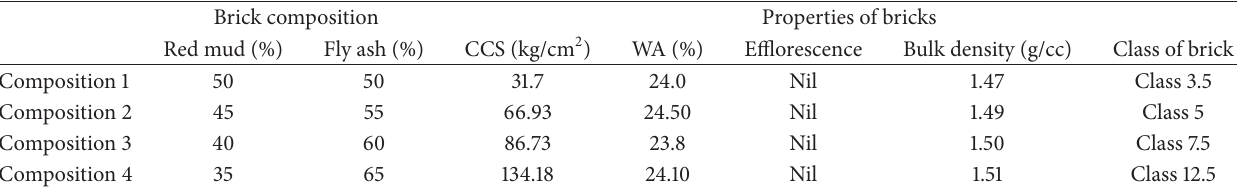
Table 6: Composition and properties of